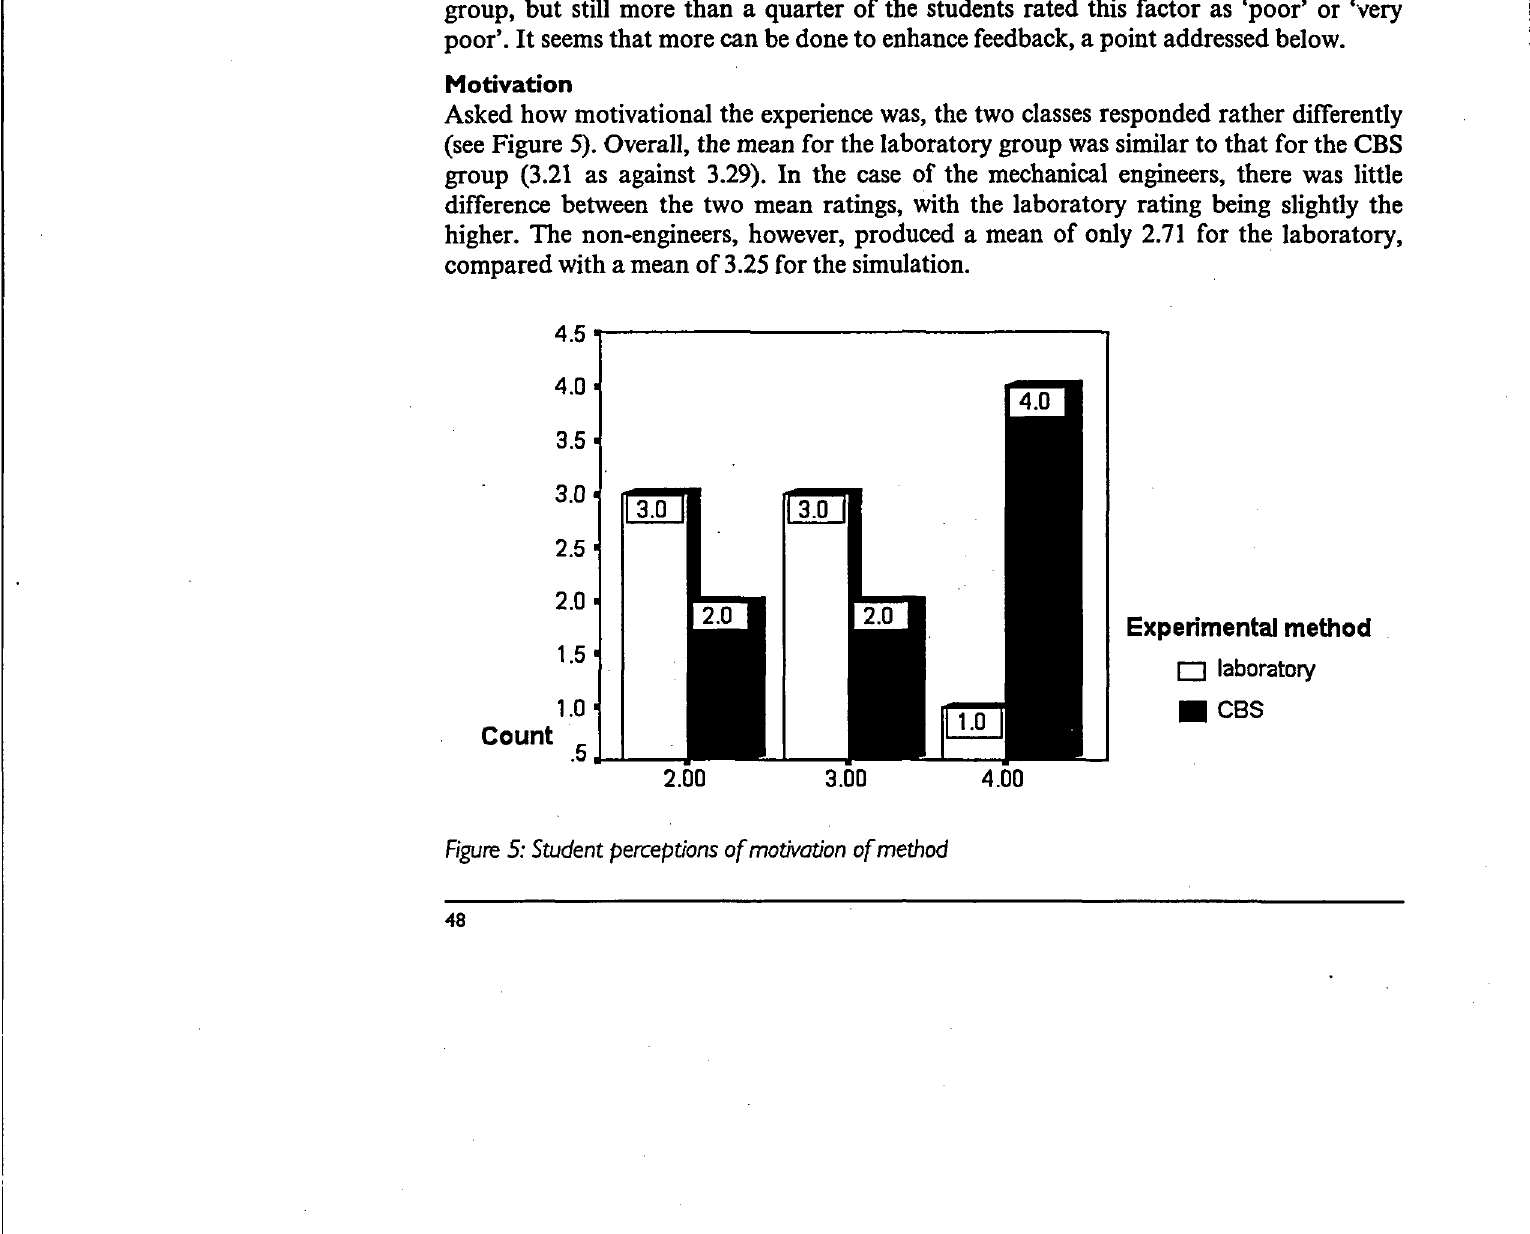
Figure 5: Student perceptions of motivation of